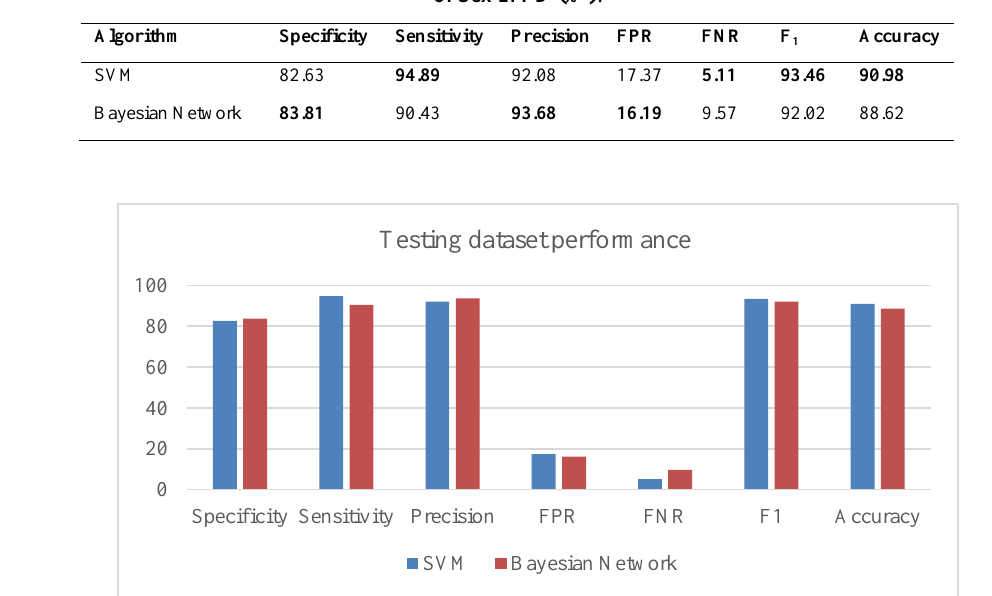
Table 3. Comparison of performance of SVM and Bayesian network algorithms through using testing dataset for prediction of Sex in PD (%) .